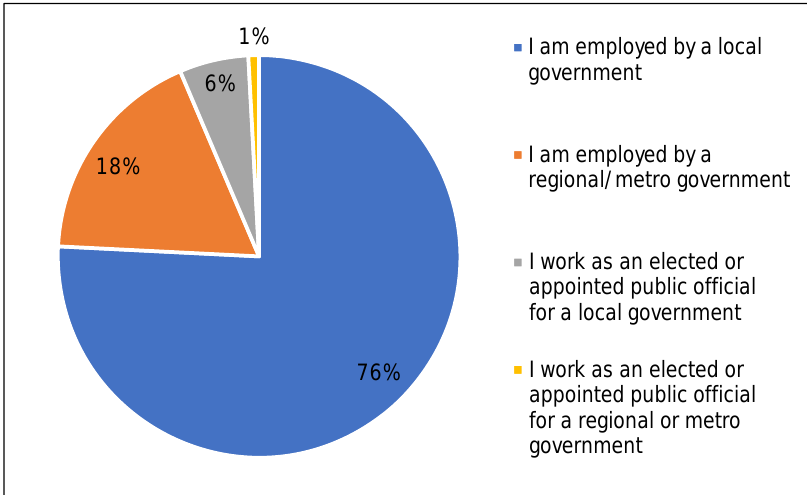
Figure 2. Proportion of APA Member Respondents Employed by Local, Regional, and Metropolitan (LRM) Governments ( n =1,169), by Type of